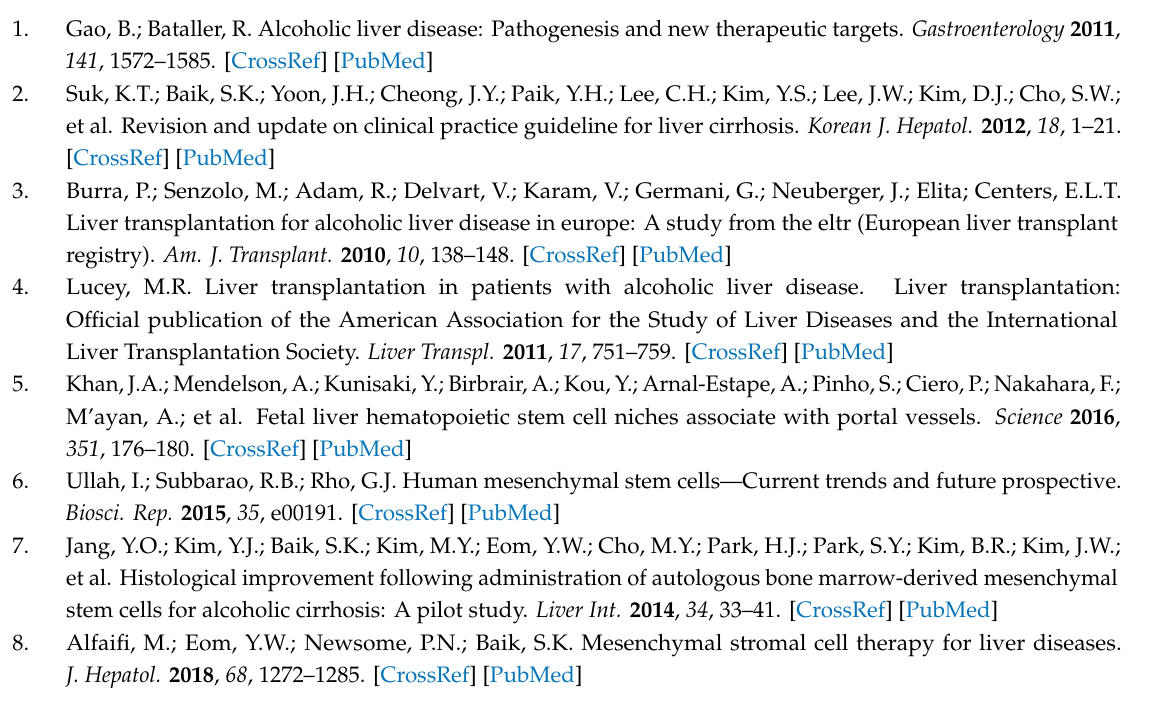
Supplement Table S1: Multivariate analysis of predictive factors for the responder, Supplement Table S2: Significant cellular process between alcoholic cirrhosis and control group, Supplement Table S3: Top 10 biological process between alcoholic cirrhosis and control group, Supplement Table S4: Significant molecular function between alcoholic cirrhosis and control group, Supplement Table S5: Profiling of up or down regulated gene expression in BM derived MSCs between alcoholic cirrhosis and control